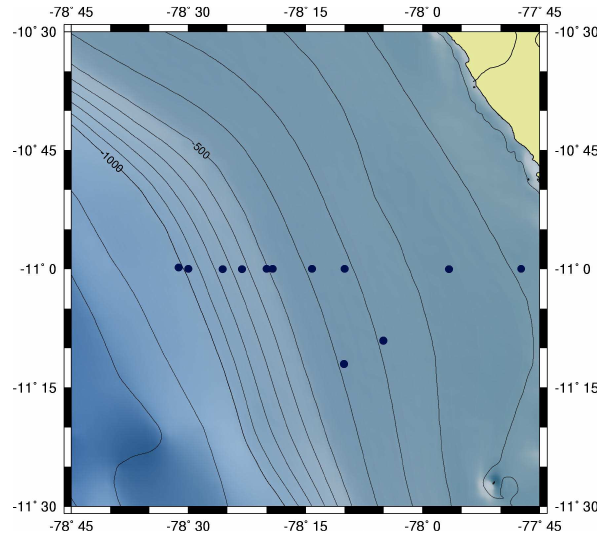
A4: Pore water nitrate profiles at different water depths along the Peruvian OMZ, including bottom water nitrate concentrations. Profiles on the left represent data from cores sampled with rhizons or in a glovebag. Profiles on the right represent data from cores sampled with a pore-water press. Informations about the sampling sites are shown in table A2 . Fig. A1. Map of sampling sites for pore water nitrate profiles.